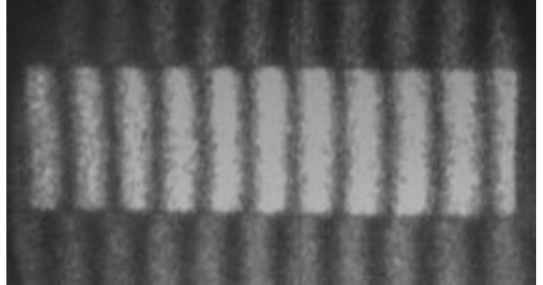
Fig. 3. The fringe